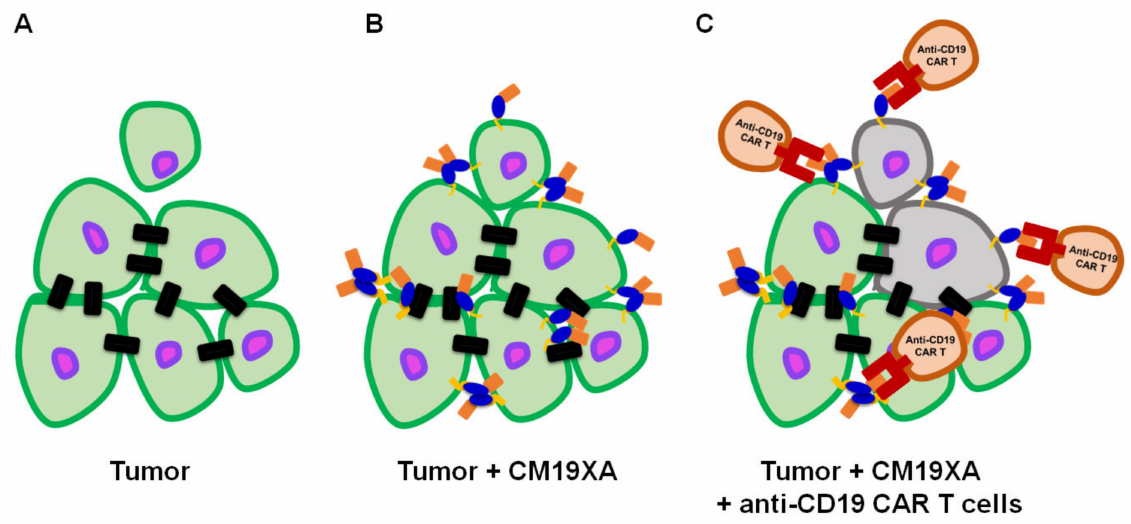
Figure 7. CM19XA mechanism of action. ( A ) Tumor formed by cells (green with purple nucleus) establishing cell–cell interactions (black rectangles). One cell poses a risk for metastasis after losing cell attachments to the main tumor. ( B ) pHLIP (yellow) inserts itself into the membrane of cancer cells. JAM-A (blue) binds to other JAM proteins in the existing cell–cell interactions in trans allowing for homotypic or heterotypic interactions to occur. Additionally, CM19XA may establish de novo cell–cell interactions by creating trans homotypic interactions. CM19XA will restrain weakly interacting cells from metastasizing, decreasing proliferation and metastasis. ( C ) Anti-CD19 CAR-T cells (brown) will recognize the tumor cells displaying CD19 (coral) and proceed to eradicate the tumor